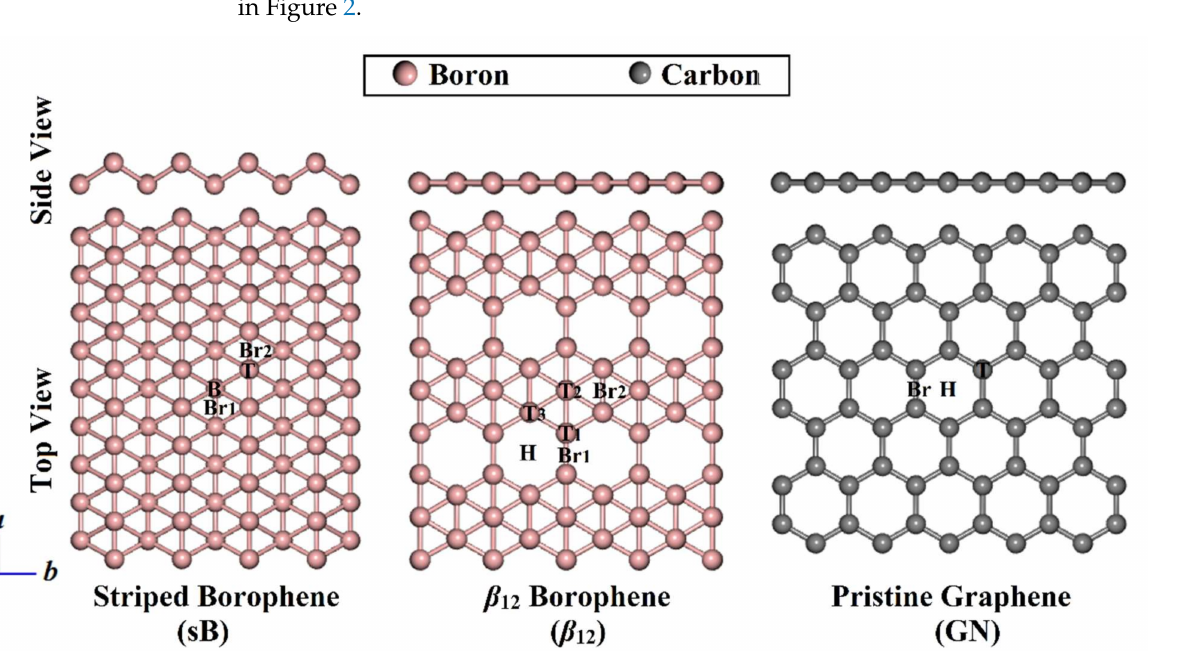
Figure 2. Side and top views of the sB-, β 12 -, and GN-optimized 2D sheets. Top (T), bottom (B), and two bridge (Br1 and Br2) sites are labeled on the surface of the sB sheet. On the β 12 surface, three top (T1, T2, and T3), one hollow (H), and two bridge sites (Br1 and Br2) are depicted. Three adsorption sites, namely, top (T), hollow (H), and bridge (Br) sites are illustrated on the GN